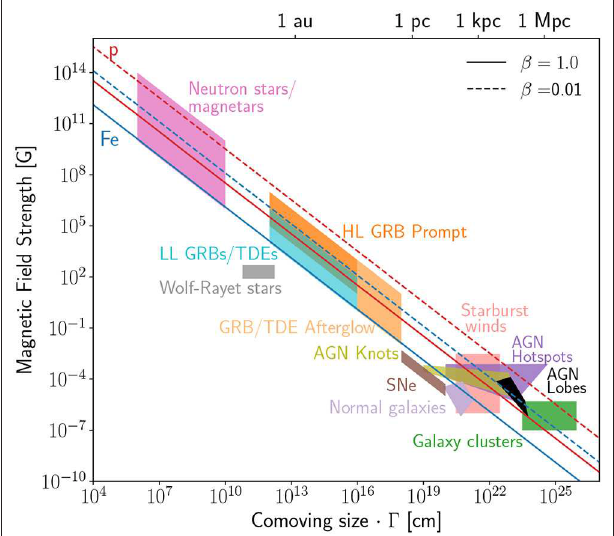
FIGURE 10 | Hillas diagram. Source classes are shown as function of their characteristic size, R , and magnetic field strength, B , in the ideal, Bohm limit, where η 1. Quoted values of B are in the comoving frame of the source. The = abscissa gives R, the radius from the engine, which is equal to comoving size of the source times the Lorentz factor of the flow, Ŵ . Solid (dashed) lines indicate the BR product beyond which confinement of protons (red) and iron (blue) nuclei with energy 10 20 eV are possible for outflows with velocity, β sh = 1 ( β sh = 0.01). Inferred values of B and R for low-luminosity gamma-ray bursts (LL GRBs) and high-luminosity GRBs (HL GRBs) are from Piran (2005) and Murase et al. (2008b). For tidal disruption events they are based on the prototypical jetted-TDE Swift J1644+57 (Burrows et al., 2011; Kumar et al., 2013; Senno et al., 2017 ), for starburst galaxies and normal galaxies they were estimated in Thompson et al. (2006). Inferred values of B and R for AGN lobes, hotspots, and knots, were presented in Kataoka and Stawarz (2005) and summarized in Ptitsyna and Troitsky (2010). For galaxy clusters, we used the inferred value range from Ptitsyna and Troitsky (2010). Inferred B and R values for supernovae were collected from Reynolds et al. (2012), Asvarov (2014), and Thompson et al. (2009) and for Wolf-Rayet stars from de la Chevrotière et al. (2014). For neutron stars and magnetars the quoted values of B , and R correspond to the expected UHECR acceleration sites in Arons (2003), Murase et al. (2009), and Fang et al. (2012). F. Oikonomou and K. Murase for this